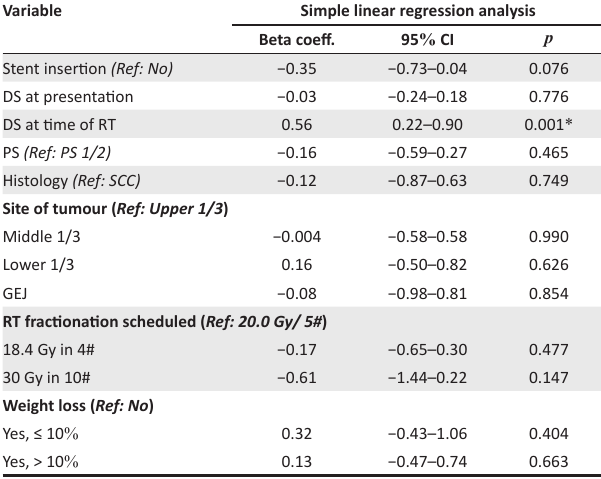
TABLE 4: Simple linear regression analysis for variables associated with mean objective change in dysphagia score. Variable